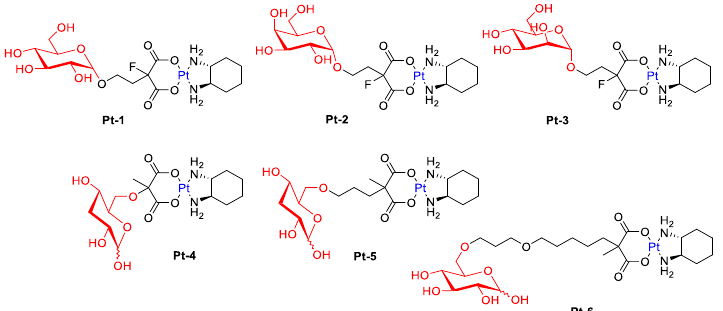
Figure 4. Representative Pt-complex glycoconjugates (conjugated via C-1: Pt-1 – Pt-3 and conjugated via C-6: Pt-4 – Pt-6).